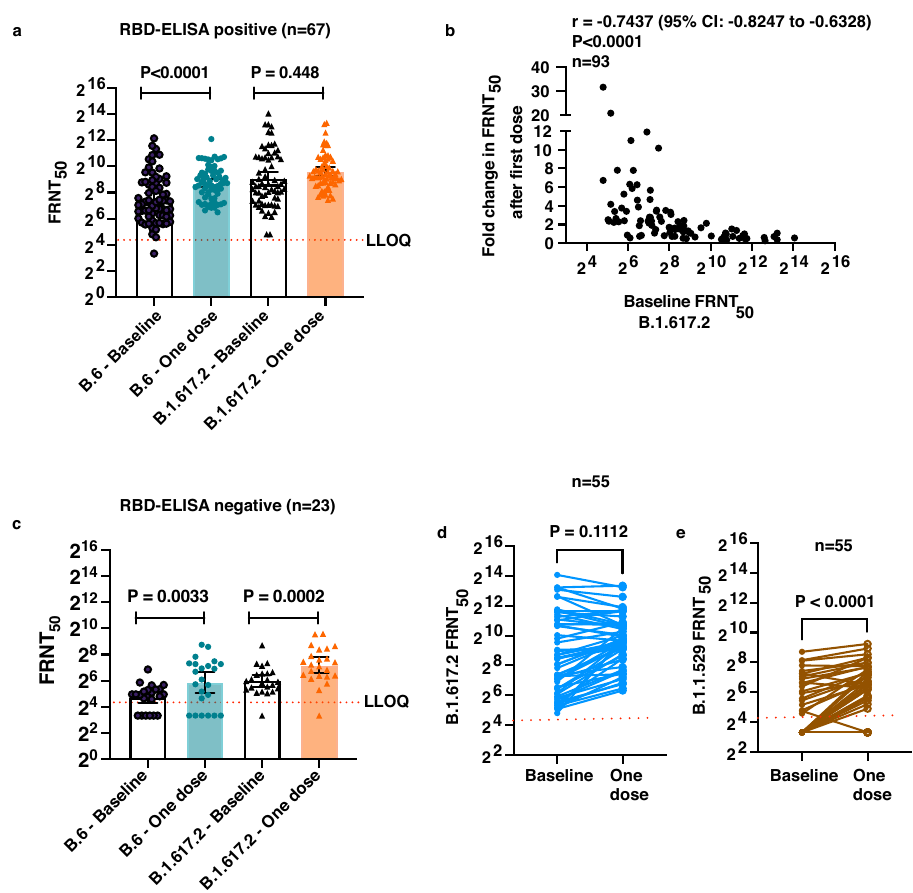
Fig. 2 Neutralizing antibody titers after single dose of BBV152 vaccination. a FRNT 50 titers in RBD-ELISA-positive samples for the ancestral B.6 lineage (circle symbols) and the Delta variant (B1.617.2) (triangle symbols) in baseline (clear bars) and post single- dose (shaded bars) vaccination samples ( n = 67 independent values). b FRNT 50 titers in RBD-ELISA-negative samples for the ancestral B.6 lineage (circle symbols) and the delta variant (triangle symbols) in baseline (clear bars) and post single-dose (shaded bars) vaccination samples. Data are presented as geometric mean with 95% con fi dence intervals ( n = 23 independent values). c Spearman correlation ( r ) between baseline FRNT 50 titers for B1.617.2 and fold change observed after single dose of BBV152 vaccination ( n = 93 independent XY pairs) ( d , e ) FRNT 50 titers for the B1.617.2 variant and Omicron (1.1.529) variant in baseline and post single- dose vaccination samples ( n = 55 independent values). LLOQ: Lower limit of quantitation of the assay. Two-tailed P values were estimated by Wilcoxon matched-pairs signed-rank test. Source data are provided as a Source data fi